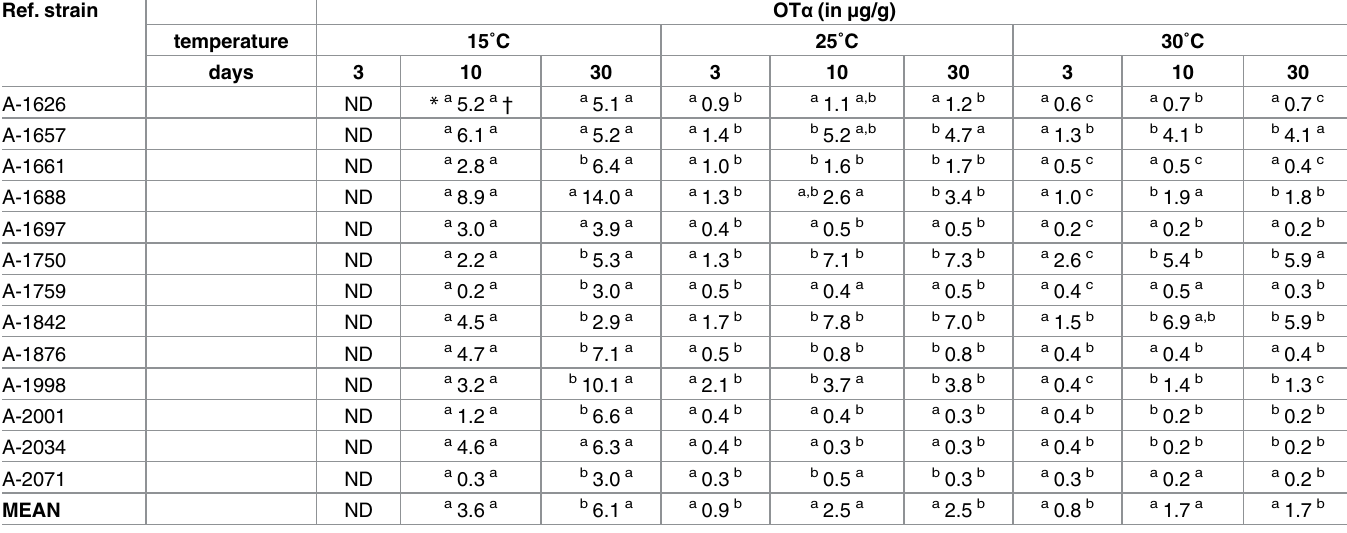
Table 3. Ochratoxin alpha (OT α concentration (mean value in μ g/g) detected in the 13 ochratoxigenic strains in CYA at each temperature and incu- bation time tested. Ref.